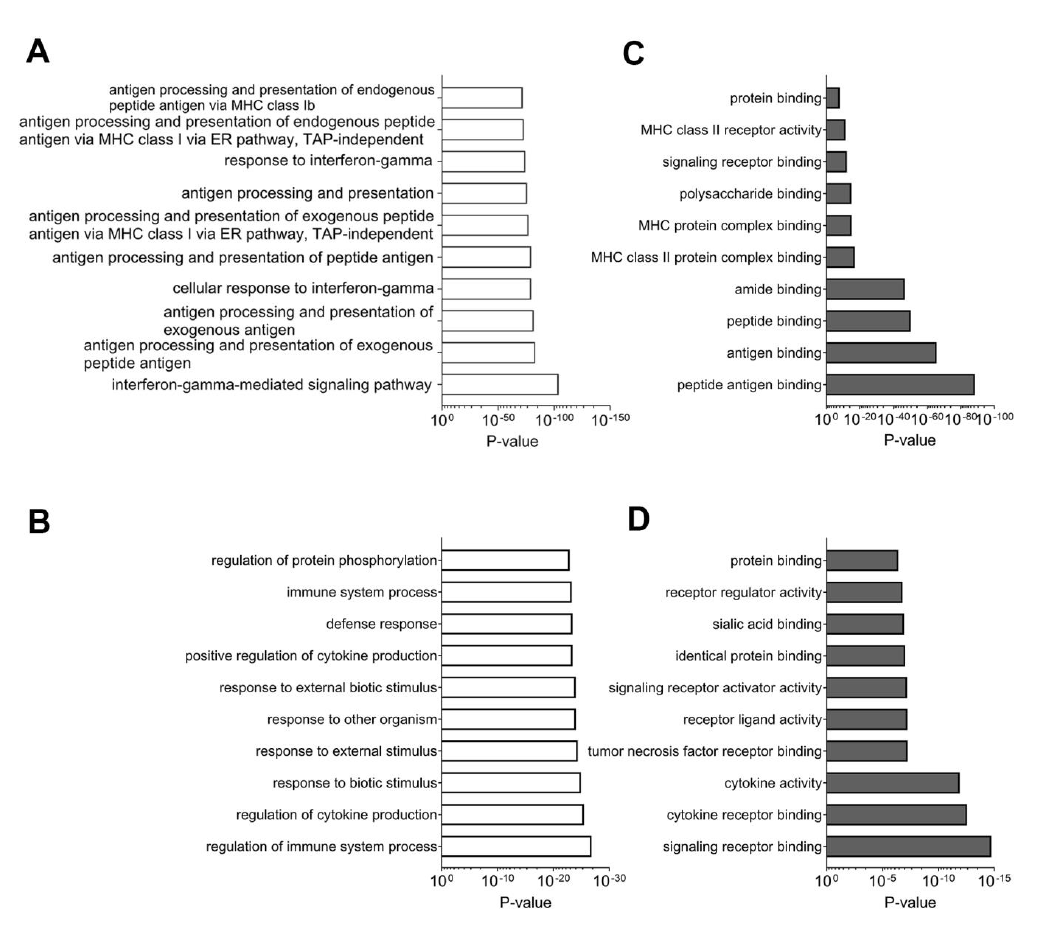
Figure 2. Public gene ontology analysis of candidate genes of proteomics and targeted-mRNA analysis. ( A , B ) Analysis for public gene ontology (GO): biological processes. ( A ) Proteomics dataset. ( B ) Targeted-mRNA dataset. ( C , D ) Analysis for public GO: molecular function ( C ) proteomics dataset ( D ) targeted-mRNA dataset.